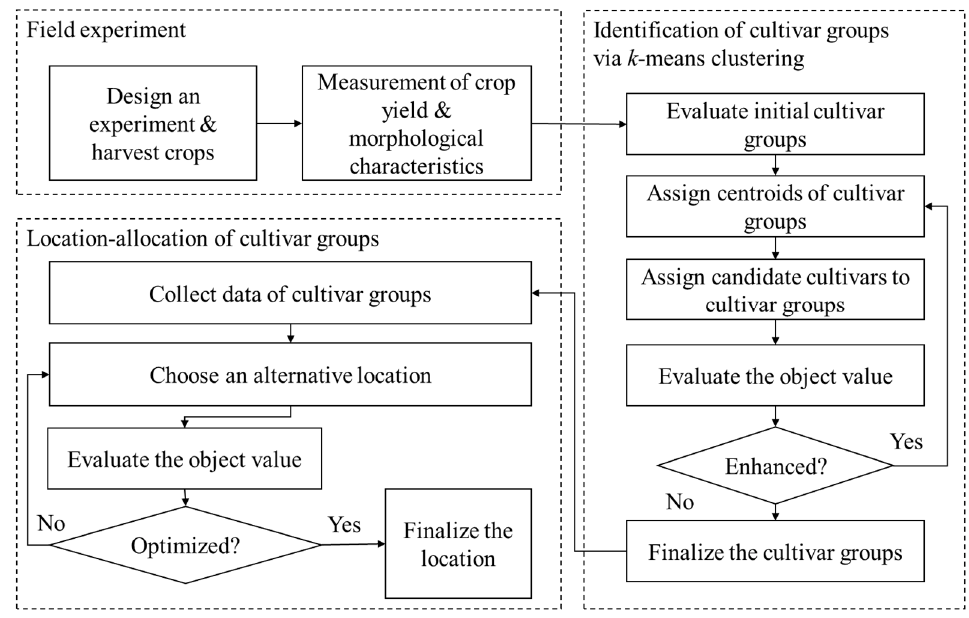
Figure 1. An overview of the proposed research framework for location–allocation of rice farming sites.